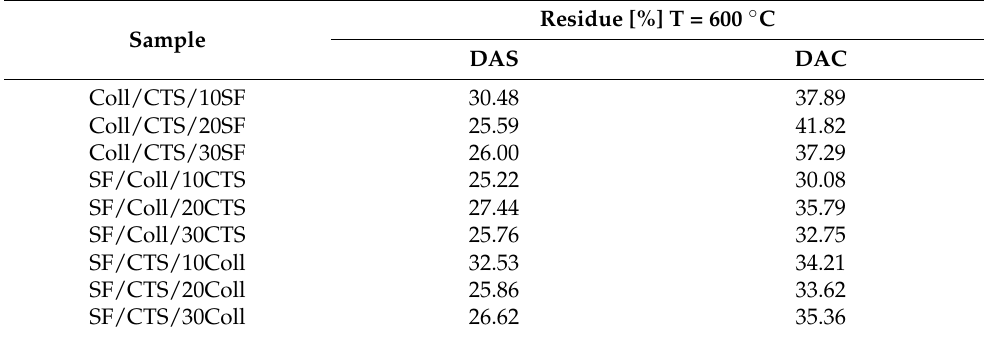
Table 4. The residue of scaffolds cross-linked with dialdehyde starch (DAS) and dialdehyde chitosan (DAC) after